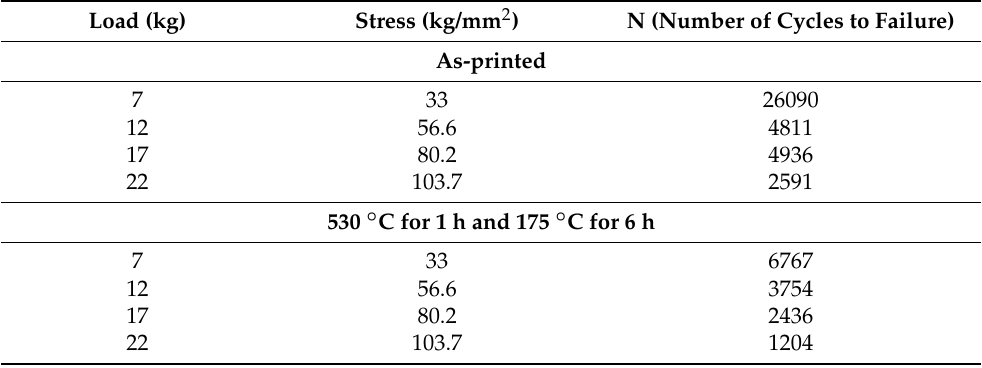
Table 5. Fatigue resistance of the Al-Ni-Cu alloy before and after solution treatment. Load (kg) Stress (kg/mm²)